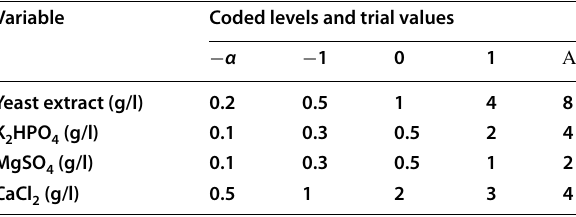
Table 2 Significant variables and their levels in CCD affecting on luminescence intensity of strain Vibrio sp.